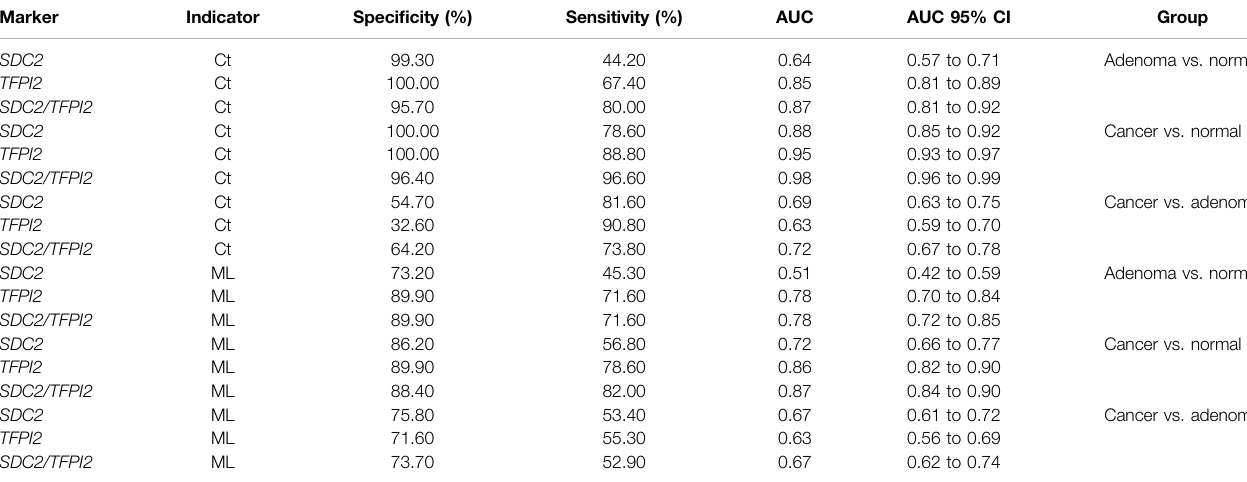
TABLE 4 | Diagnostic performance of methylation-speci fi c PCR in stool specimens with the Ct value and ML as indicators a .